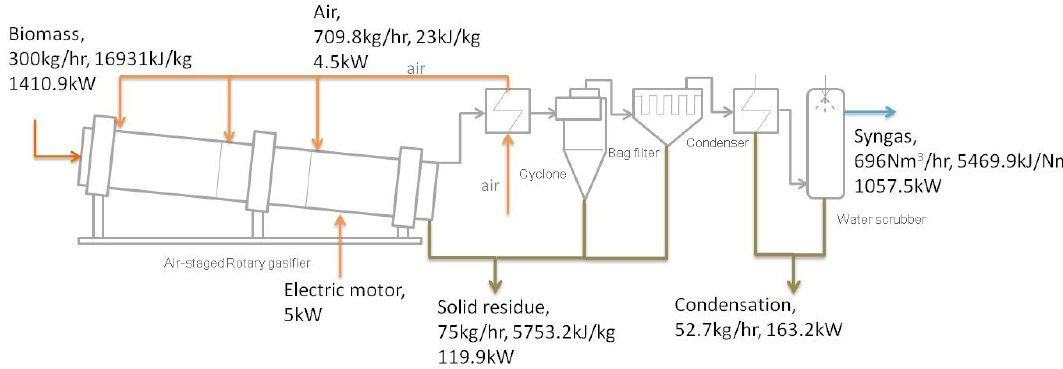
Figure 14. Energy input and output of the gasification system. Table 3. Proximate and ultimate analysis of the solid residue.